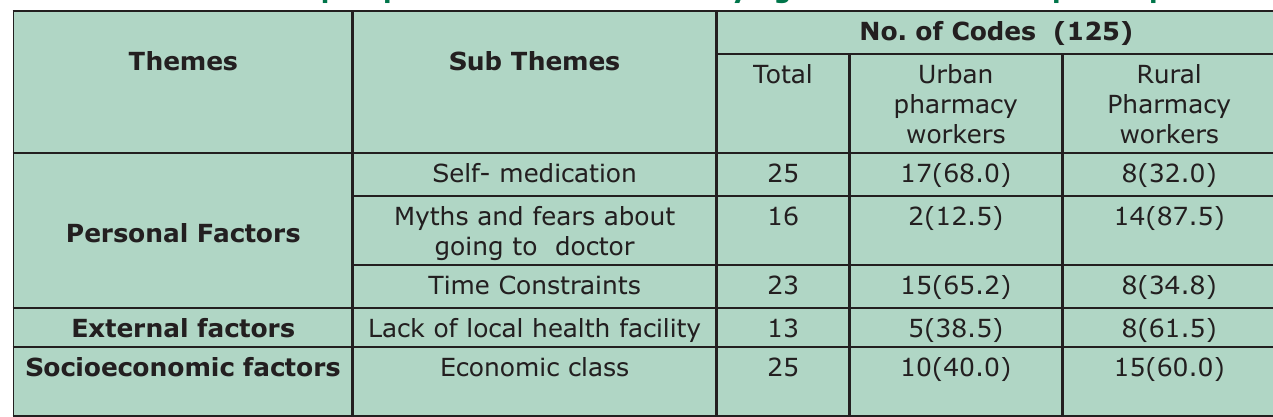
Table-IV: : Breakup of perceived reasons for buying medicine